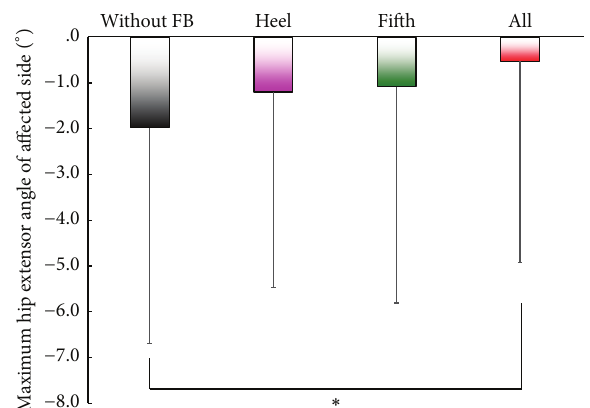
Figure 4: Effects on the maximum hip extension angle of the affected side during the stance phase. ∗ 𝑝 < 0.05 , two-tailed. A significant difference was observed between (i) “without” and (iv) “all”